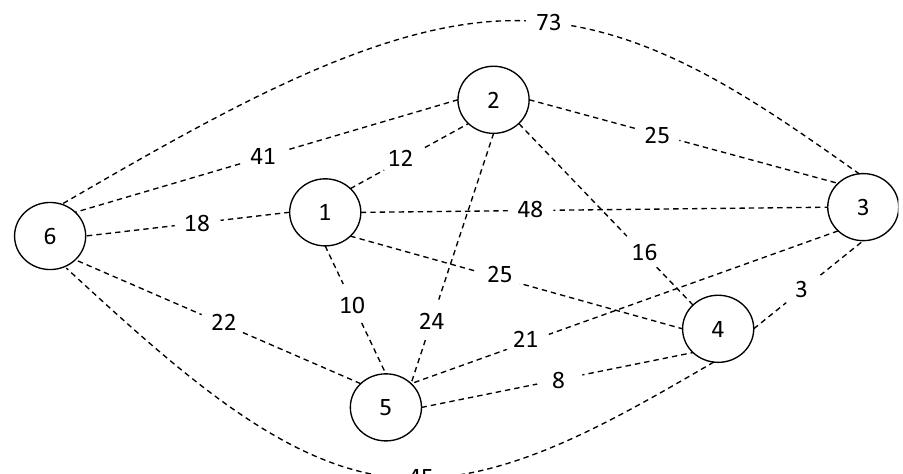
Figure 1. A sample undirected, connected network.